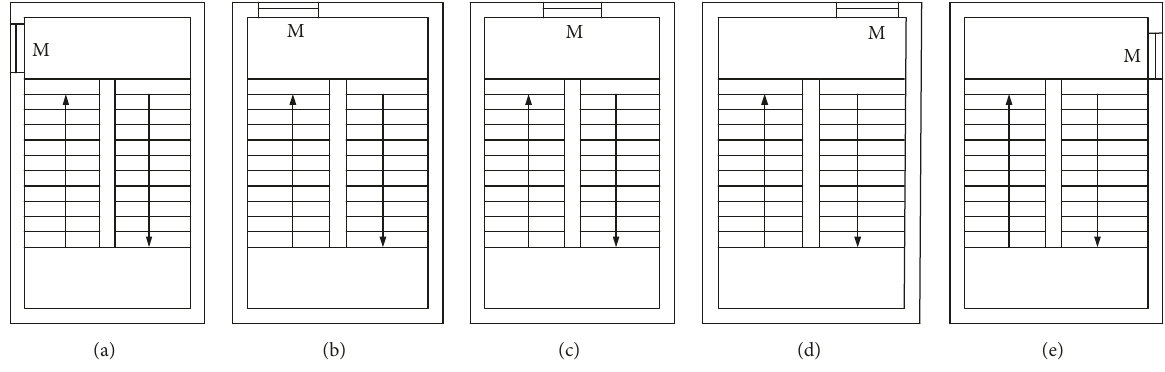
Figure 2: The merging form of stairs when there is one floor entrance and the floor entrance is set in different positions.